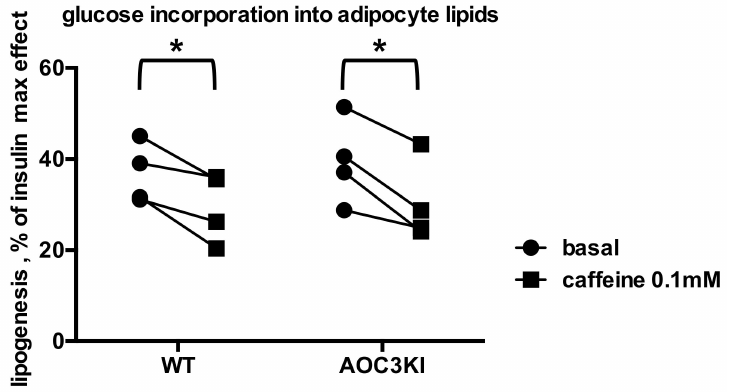
Figure 9. Caffeine inhibits basal lipogenesis in mouse adipocytes irrespective of their SSAO/PrAO activity level. Lipogenesis is expressed as percentage of maximal activity, with 100% corresponding to glucose incorporation into lipids in response to 100 nM insulin. Each couple of points corresponds to a preparation of adipocytes from wild type (WT) or transgenic (AOC3KI) mouse, incubated without (basal, circles) or with 0.1 mM caffeine (squares). Different from corresponding basal by paired t test at: * p <